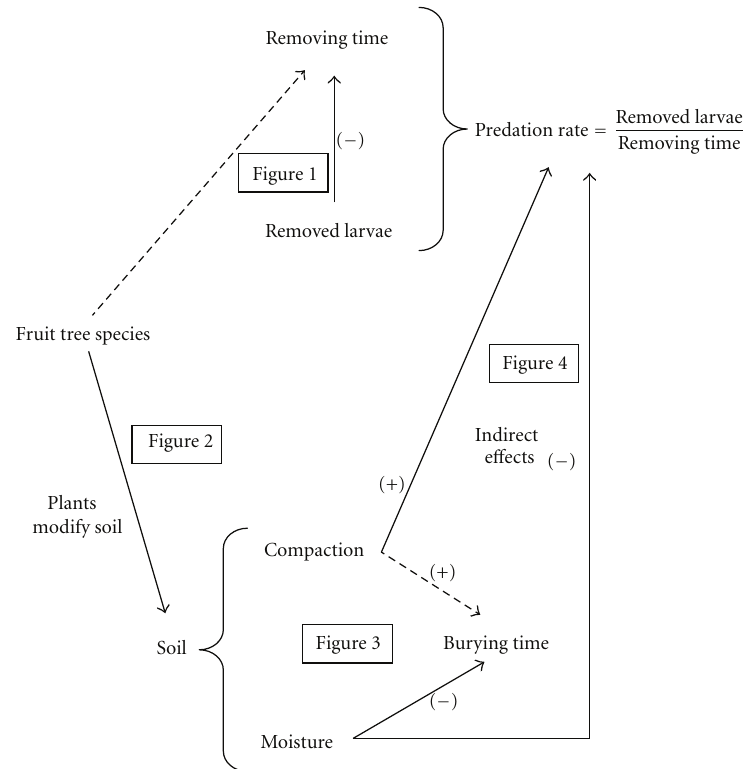
Figure 5: E ff ects’ diagram for predation of fruit fly larvae by ants. Evidences for e ff ects are in the indicated figures. Dashed lines: no statistical evidence; (+): positive e ff ect; ( − ): negative e ff